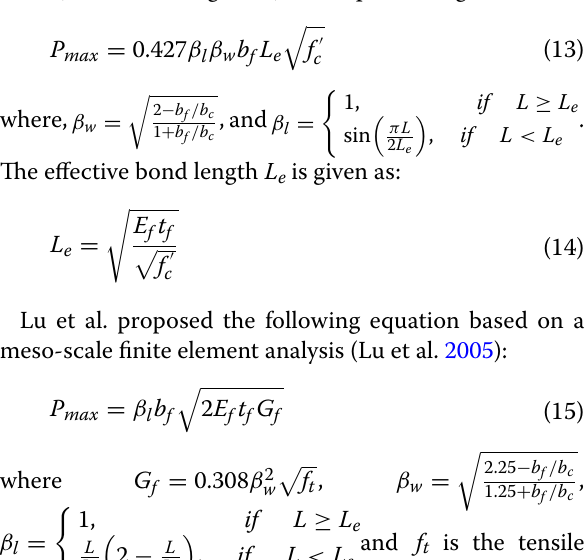
composite(See figure on next Fig. 7 Loads responses of single-lap shear specimens with MD fibers and bonded length L MD_120_8 not shown), e 150 mm, f 180 mm, g 210 mm (Note MD_210_7_D not shown), and h 240 mm. All specimens shown failed due to debonding of the